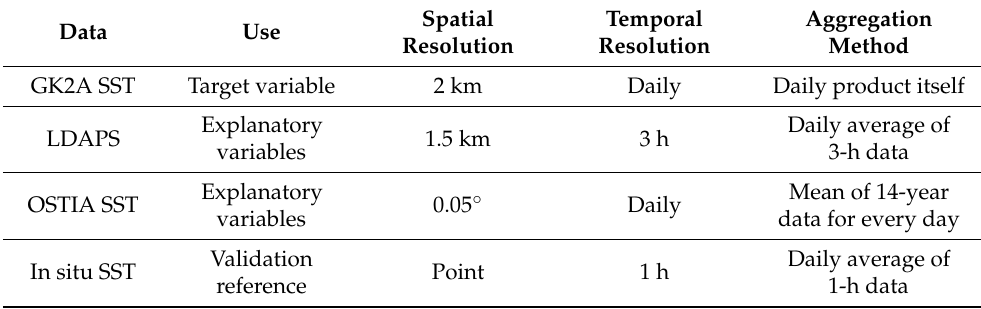
Table 1. Summary of the data used in this study. Data Use GK2A SST Target variable 2 km Daily product itself Explanatory LDAPS variables Explanatory OSTIA SST variables